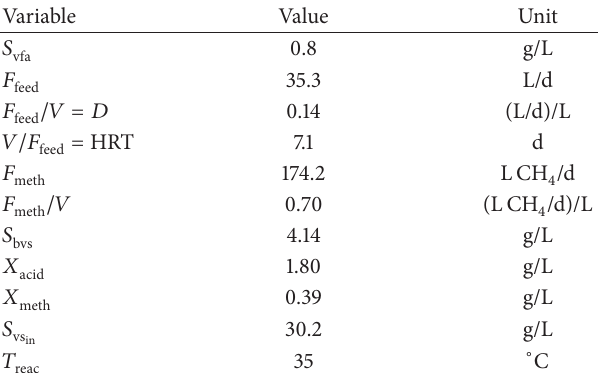
Table 2: The ultimate safe steady-state operating